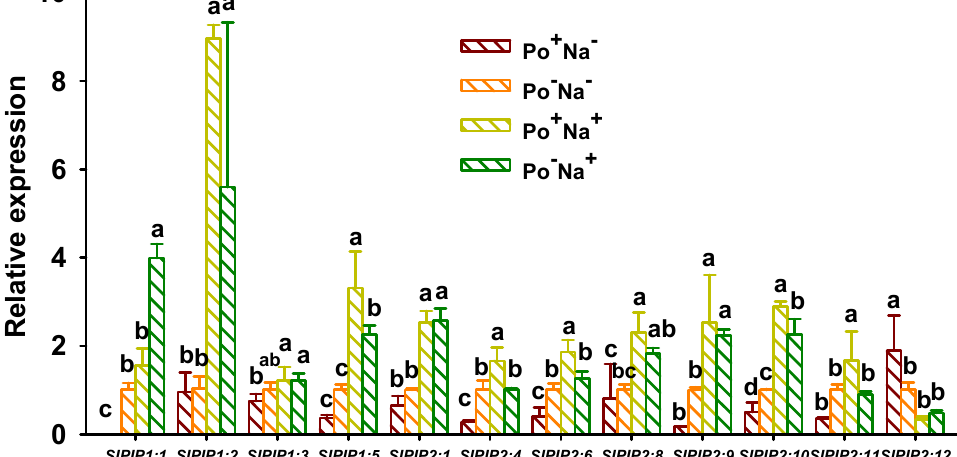
Figure 3. Changes in leaf SlPIP1 and SlPIP2 expressions of tomato plants colonized by Paraglomus occultum under 0 and 150 mM NaCl stress. Data (means ± SD, n = 3) followed by different letters on the bar indicate significant differences among treatments at the 0.05 level. See Table 1 for abbrevia- tions.